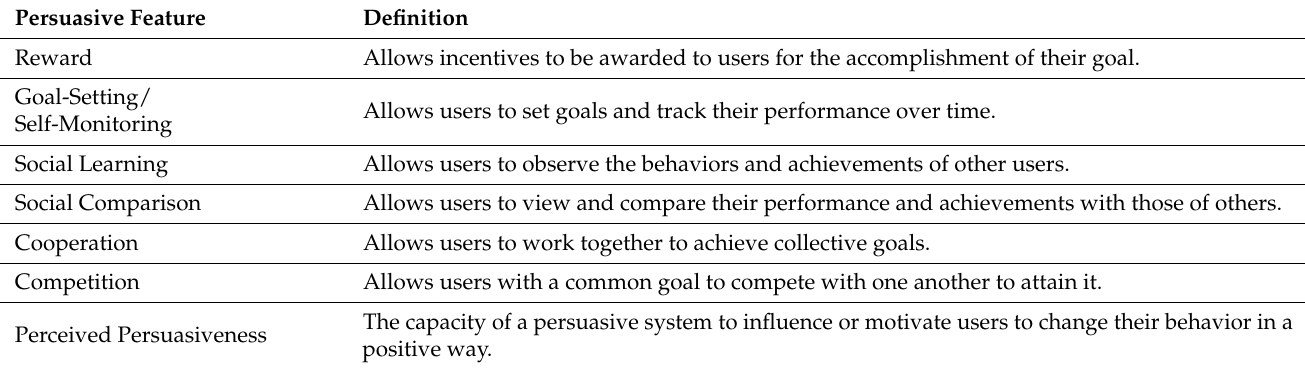
Table 2. Persuasive features and definition